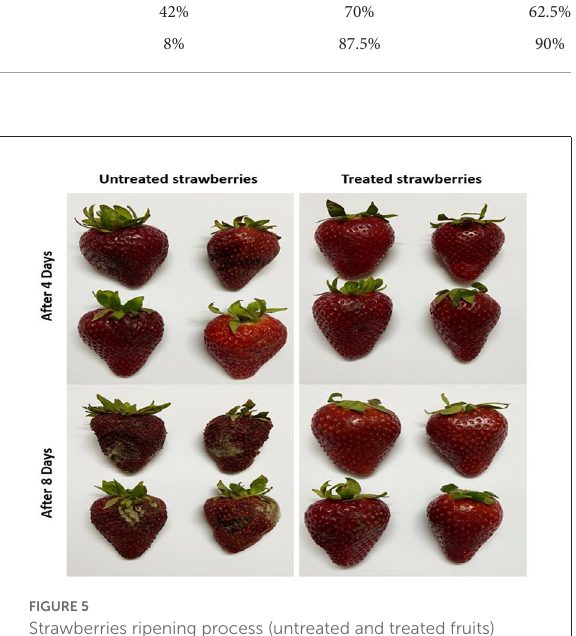
FIGURE5 Strawberries ripening process (untreated and treated fruits) during